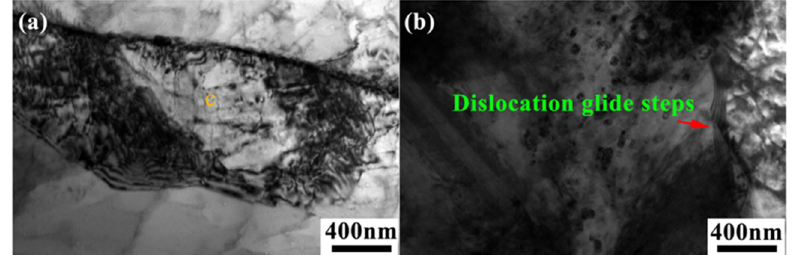
Figure 3: ( a ) Transmission electron microscopy ( TEM ) image of the dislocation cell labeled with orange “ c. ” ( b ) Dislocation glide steps marked with a red arrow in the MgO/Mg nanocomposite [ 104 ] .